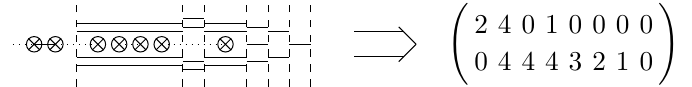
Figure 61. Example of a matrix encoding the data of a Higgs branch brane con(cid:12)guration. interval numbers ~k s of the half NS5-branes). The bottom row counts the number of half D3-branes. An g O 3 (cid:0) plane is also counted as half a D3-brane. Therefore, a column with an odd number in the bottom row corresponds to an interval with an g O 3 (cid:0) plane. Note that such column will have 0 as the top element, since there cannot be an interval with an g O 3 (cid:0) plane and one or more half NS5-branes remaining in it after the collapse transition.